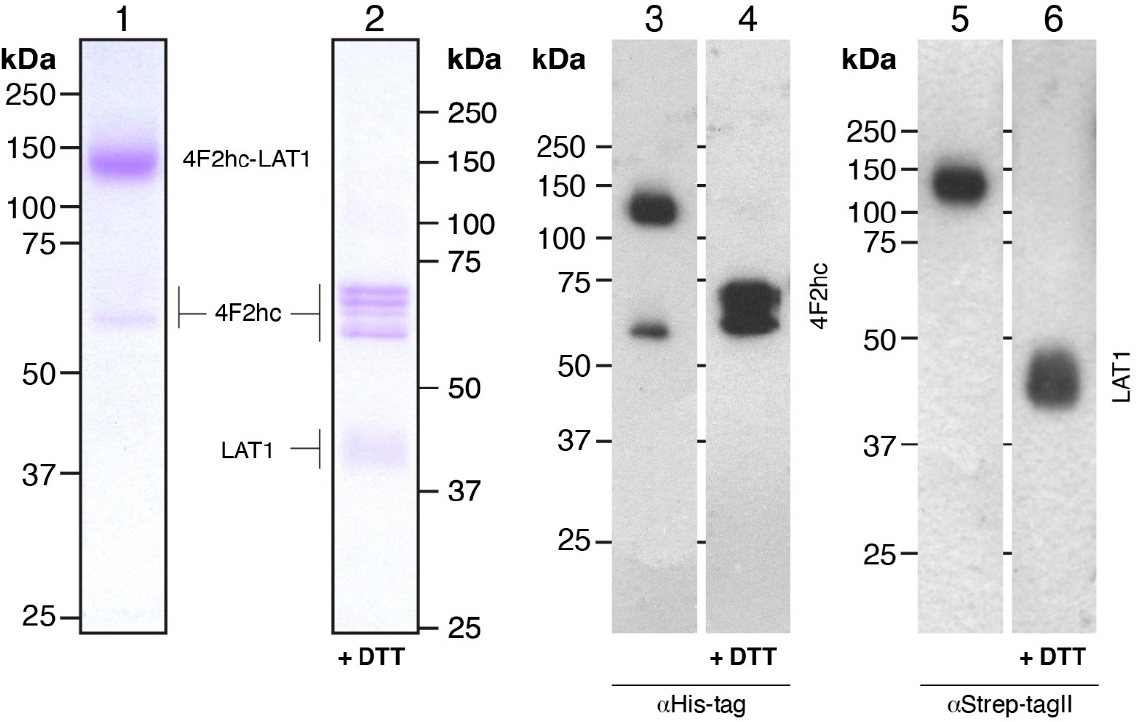
Figure 2. SDS-PAGE analysis of Coomassie Brilliant Blue-stained gels and Western blots. 4F2hc-LAT1 purified protein samples after double affinity purification were analyzed by 10% SDS-PAGE gels. Lanes 1 and 2 (1.5 µ g of protein loaded per lane) show Coomassie-stained gels, and lanes 3-6 display Western blots (0.3 µ g of protein loaded per lane). The latter were either probed with α His-tag (lanes 3 and 4) or α Strep-TagII (lanes 5 and 6) antibodies. Lanes 1, 3, and 5 and 2, 4, and 6 depict samples run under non-reducing and reducing conditions, respectively.